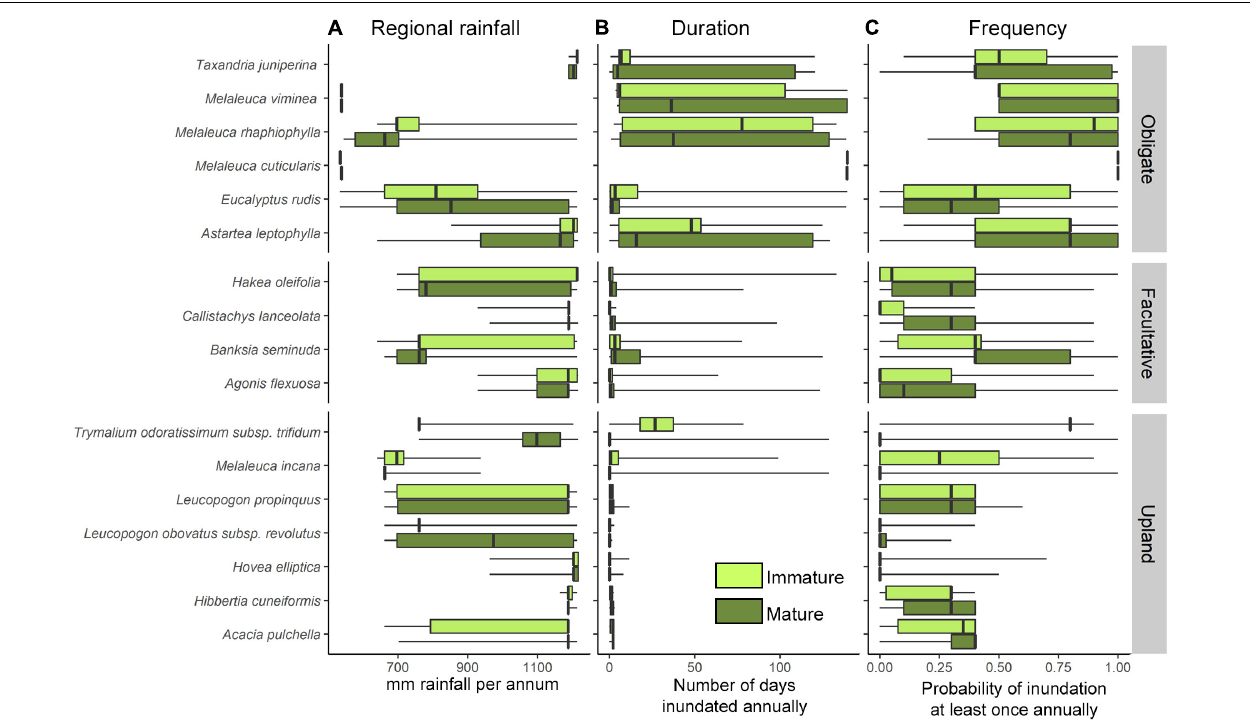
FIGURE 3 | Range of hydrological conditions estimated for mature and immature individuals inhabiting the riparian zone of the Warren River Catchment. Estimated hydrological parameters are (A) mean annual rainfall (mm), and river flow metrics flood (B) duration, and (C) frequency estimated as the recent conditions (from 2001 to 2010). The limits of boxes mark the lower and upper quartiles (25%, 75%) centered around the median (bold center line) of the species distribution. Whiskers indicate the min and max